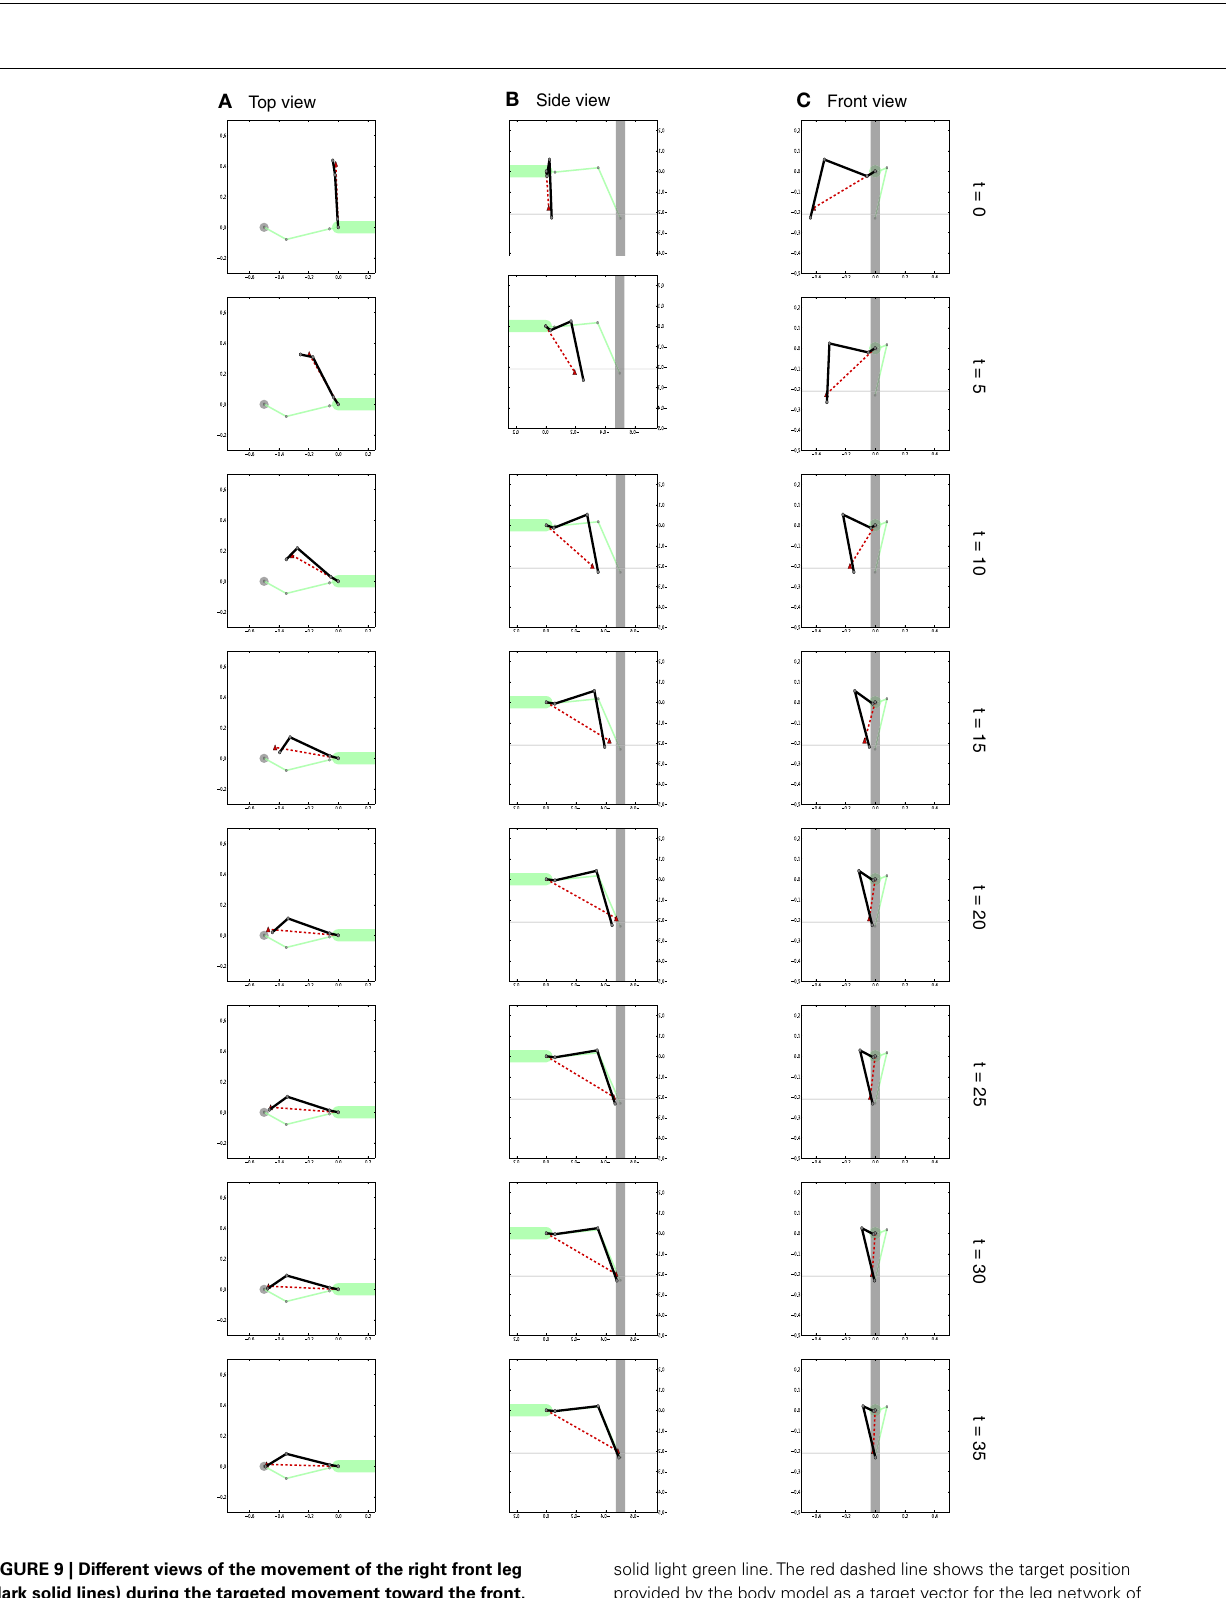
solid light green line.The red dashed line shows the target position provided by the body model as a target vector for the leg network of the right front leg.View from above is shown in (A) , side view is shown in (B) and view from the front is shown in (C) . Right: number of